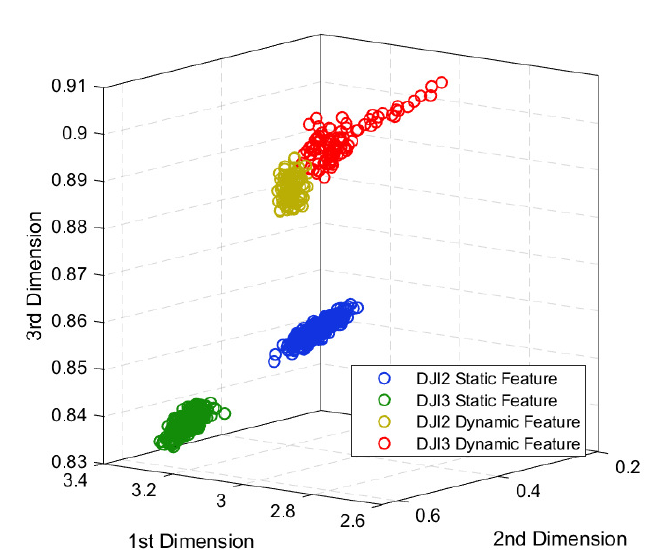
Figure 5. Three-dimensional feature distribution of UAVs.